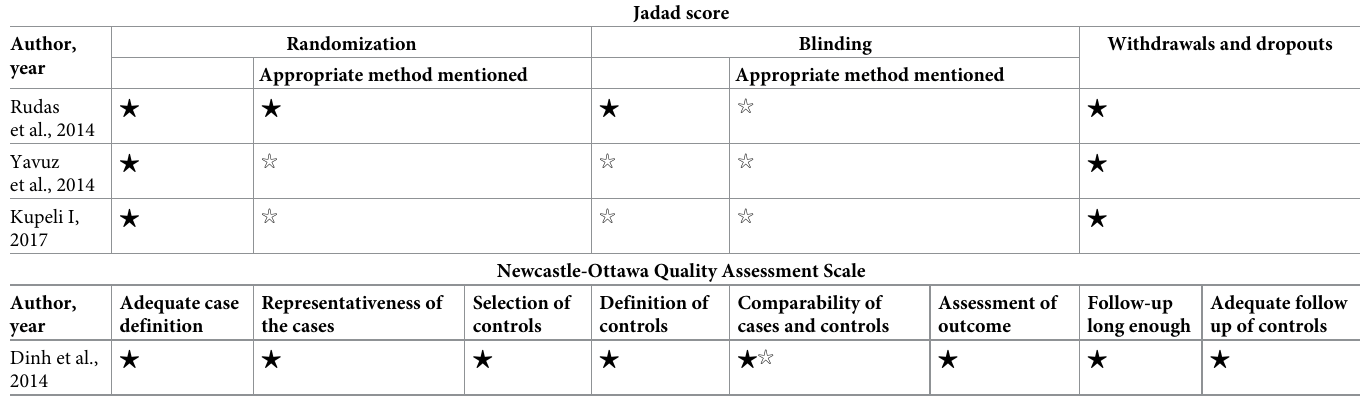
Table 2. Jadad score assessment of RCTs and Newcastle-Ottawa Quality Assessment Scale of NRS.